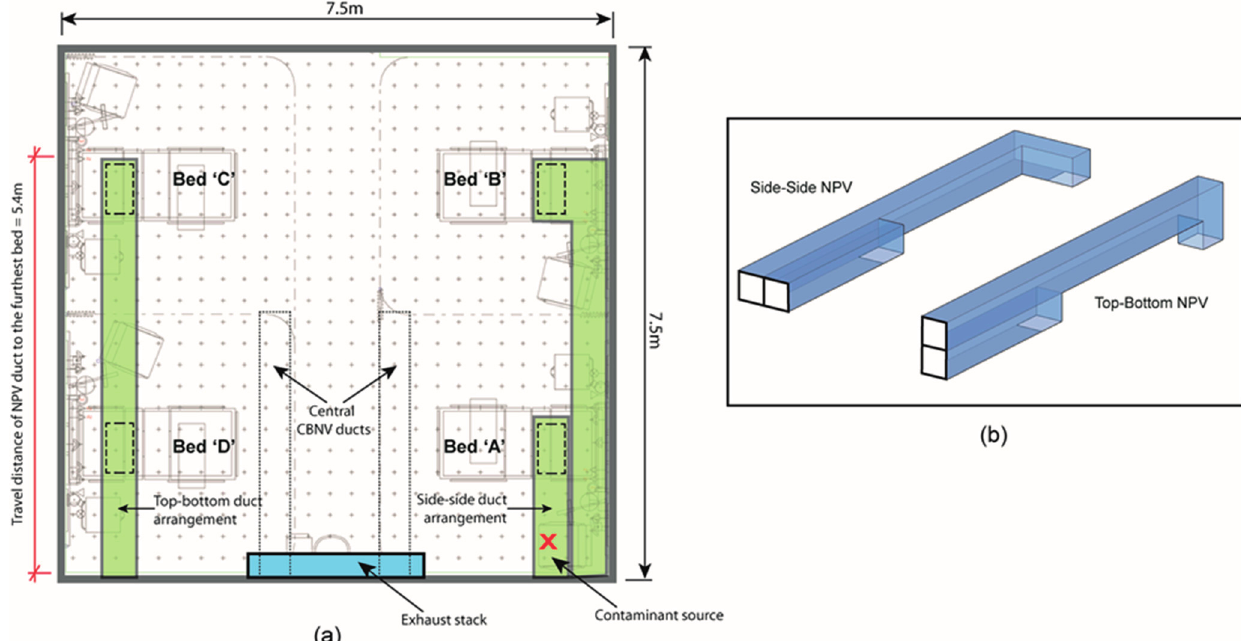
Figure 3. Layout of activity database (ADB) ward showing: ( a ) Plan view of Side–Side and Top–Bottom NPV duct locations, central CBNV ducts and two possible locations of exhaust stacks; as well as ( b ) The NPV duct designs in